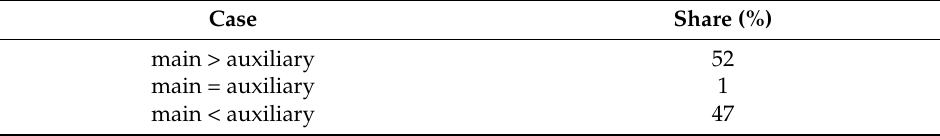
Table 4. Percentages of cases.